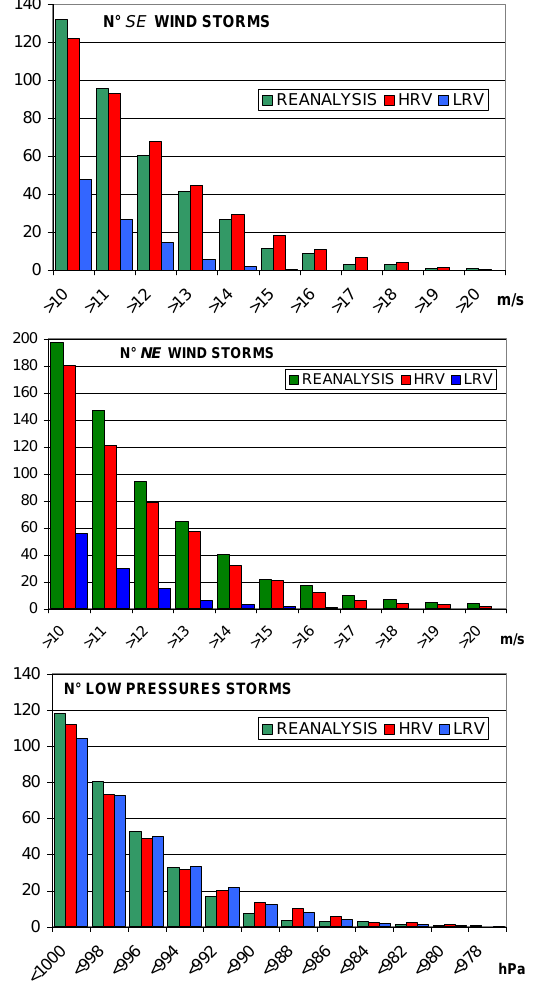
Figure 3. Number of south-easterly and north-easterly wind-storms per decade (top and mid Fig. 3. Number of south-easterly and north-easterly windstorms per decade (top and mid panels) and number of hours per decade be- panels) and number of hours per decade below a low-MSLP threshold (bottom panel) for the low a low-MSLP threshold (bottom panel) for the HRV and LRV HRV and LRV simulations and ERA-Interim at the ISMAR-CNR platform. simulations and ERA-Interim at the ISMAR-CNR platform.